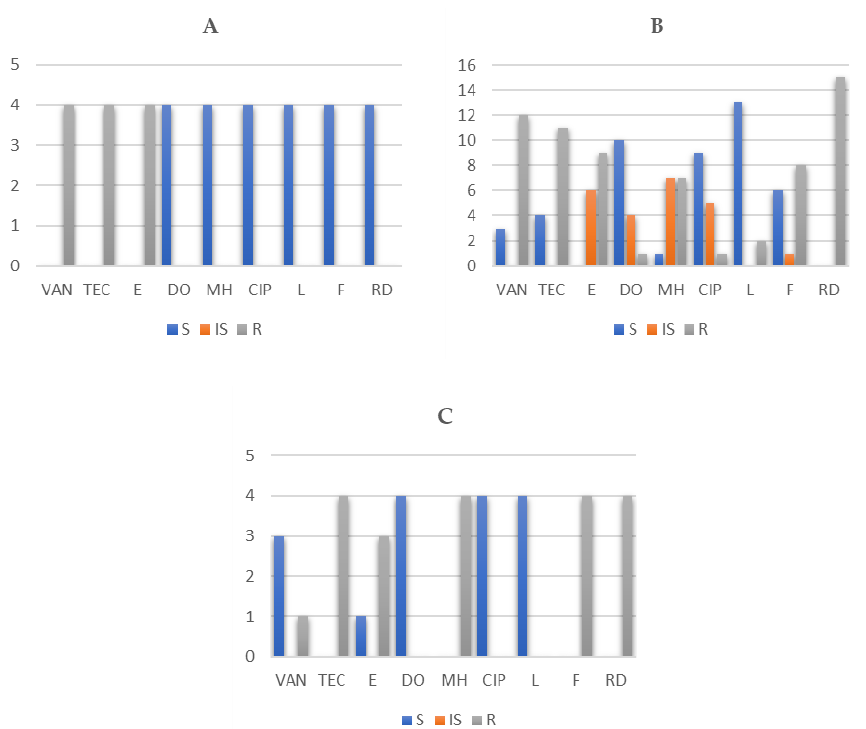
Figure 2. Number of resistant (R), intermediately resistant (IS), and susceptible (S) E. faecium ( n = 4) ( A ), E. faecalis ( n = 15) ( B ), and E. durans ( n = 4) ( C ) in sheep cheese samples. n : number strains; VAN: vancomycin; TEC: teicoplanin; E: erythromycin; DO: doxycycline; MH: minocycline; CIP: ciprofloxacin; L: levofloxacin; F: nitrofurantoin; RD: